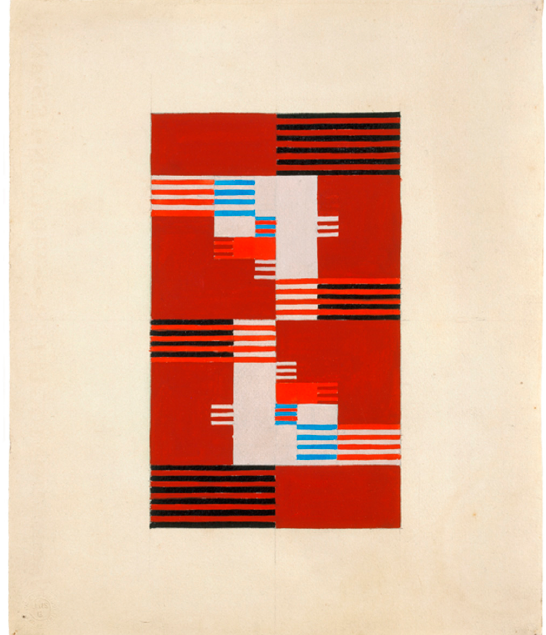
Figure 10. Sophie Taeuber-Arp, Composition, ca. 1918. Pencil and coating paint on paper. 30.7 × 25.6 cm. Kunst Museum Winterthur. Donation by Marguerite Arp-Hagenbach, 1977. © SIK-ISEA, Zürich (photo Philipp Hitz), used by permission.